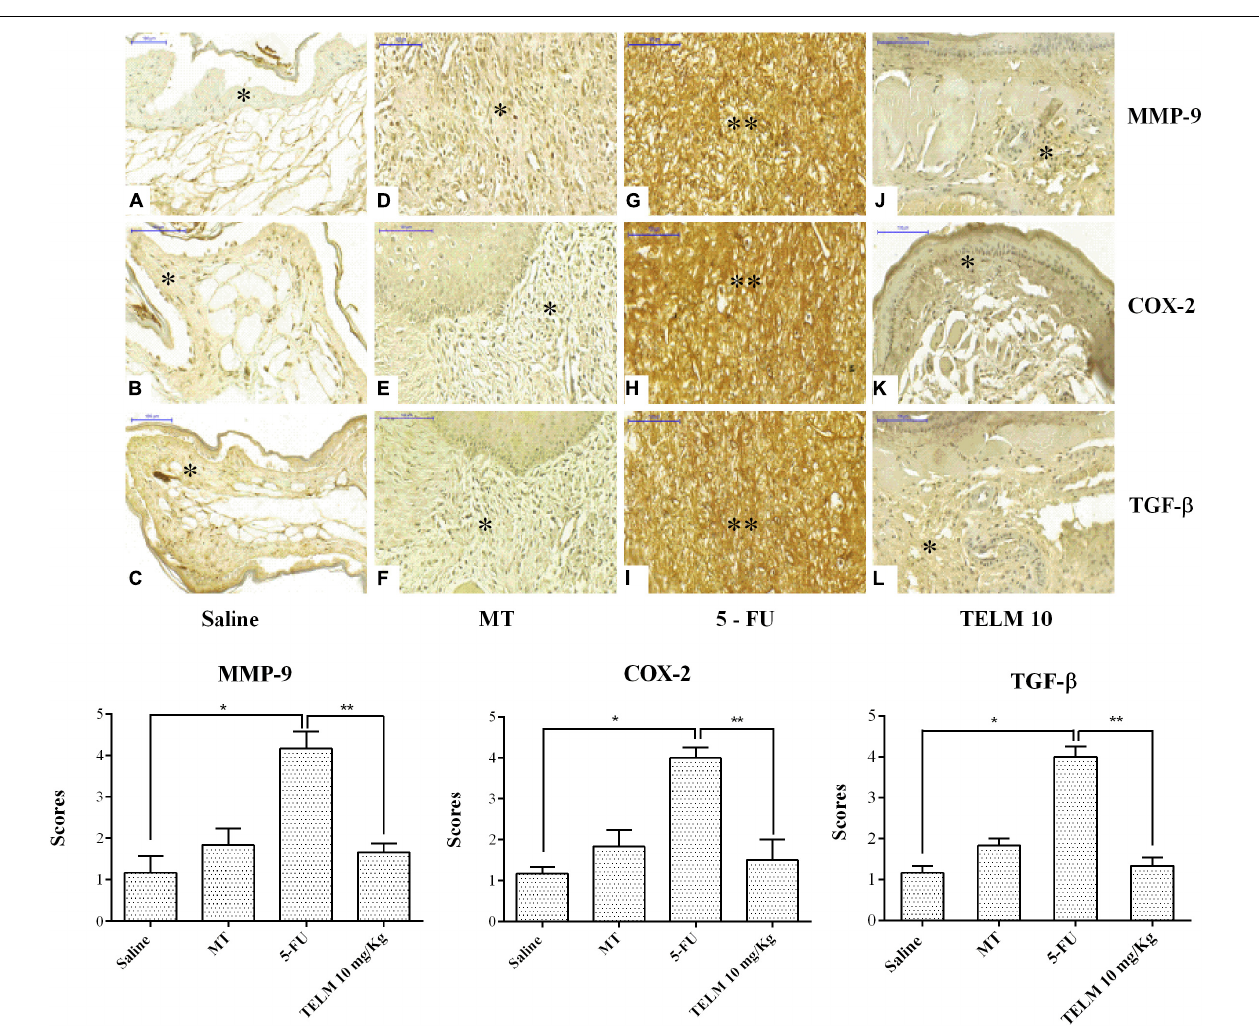
FIGURE 4 | Immunohistochemistry and scores for matrix metalloproteinase-9 (MMP-9), cyclooxygenase-2 (COX-2), and transforming growth factor beta (TGF- β ). The saline group (A – C) and the mechanical trauma (MT) group (D – F) had little immunostaining. The inflammatory cells and fibroblasts of the jugal mucosa of the 5-FU group were intensely labeled for MMP-9 (G) , COX-2 (H) , and TGF- β (I) compared to the saline group. TELM at 10 mg/kg reduced the immunostaining for MMP-9 (J) , COX-2 (K) , and TGF- β (L) , compared to the 5-FU group. The scores are represented as the medians ± standard error of the mean ( n = 5). ∗ p < 0.05 vs. the saline group, ∗∗ p < 0.05 vs. the 5-FU group (Kruskal–Wallis test and Dunn’s multiple comparison test).